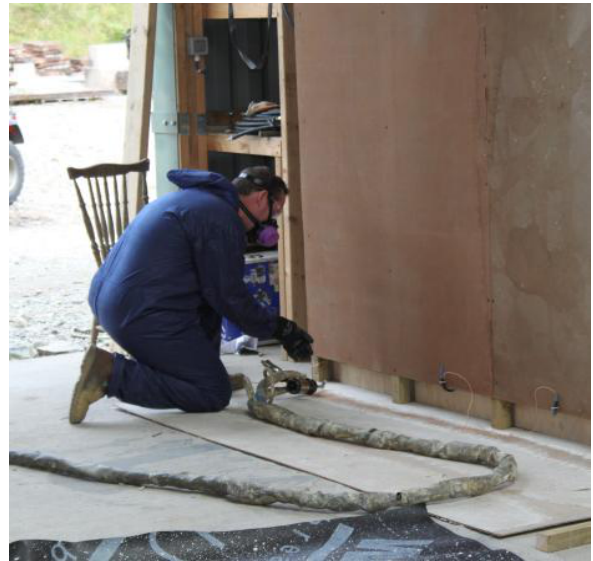
Figure 5. Trial in the